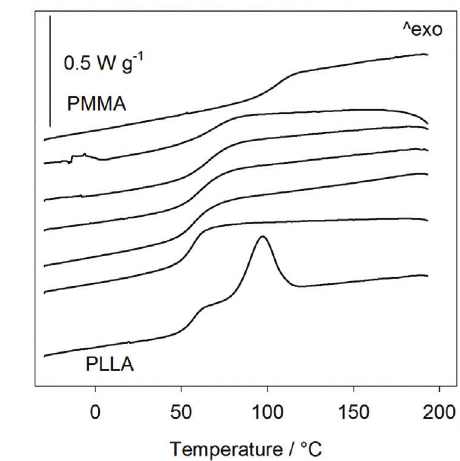
Fig. 6 – DSC cooling scan of PLLA, PMMA, and PLLA/ PMMA blends recorded at 10 °C min –1